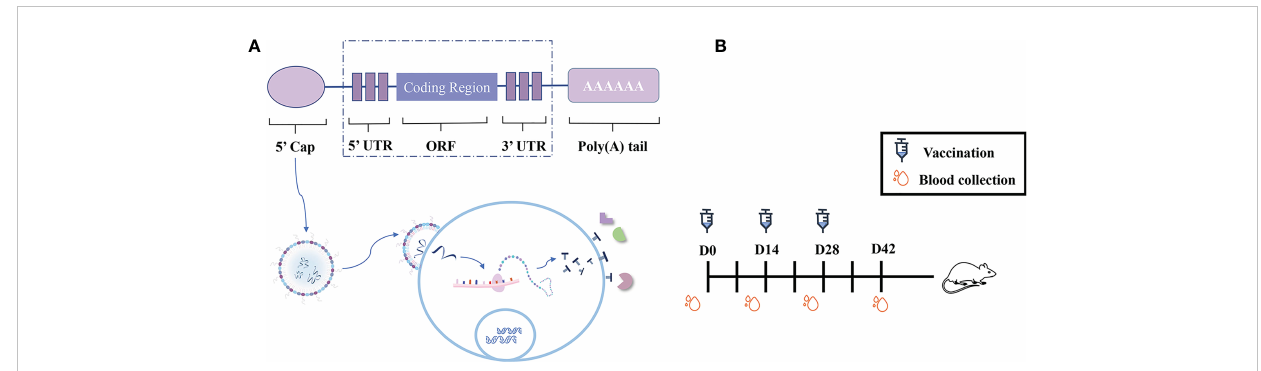
FIGURE 1 Experimental design and immunization schematic diagram. (A) Schematic diagram of the construction of TG_200 mRNA-LNP vaccine candidates and a schematic diagram showing the proposed mechanism for mRNA vaccine candidate translation in the cytoplasm. (B) Scheme of the TG_200 mRNA-LNP vaccination